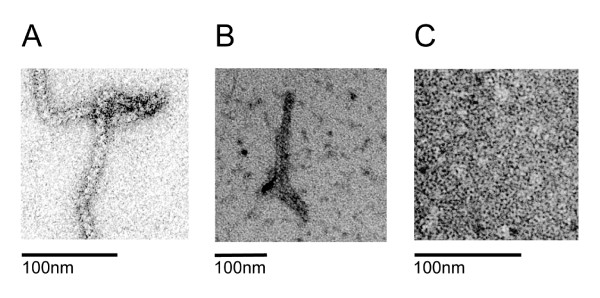
Visualization of filament formation of RecA or its variants. Circular ssDNA (10 mM in nucleotides) was pre-incubated with (1 mM) RecA (A) or variants RecA-Htg (B) or RecA-GFP (C) 20 min at 37°C in buffer C containing 20 mM NaCl and 1 mM ATPγS, and incubated for 40 min at 37°C. The specimens were prepared for electron microscopy by negative staining with 1%